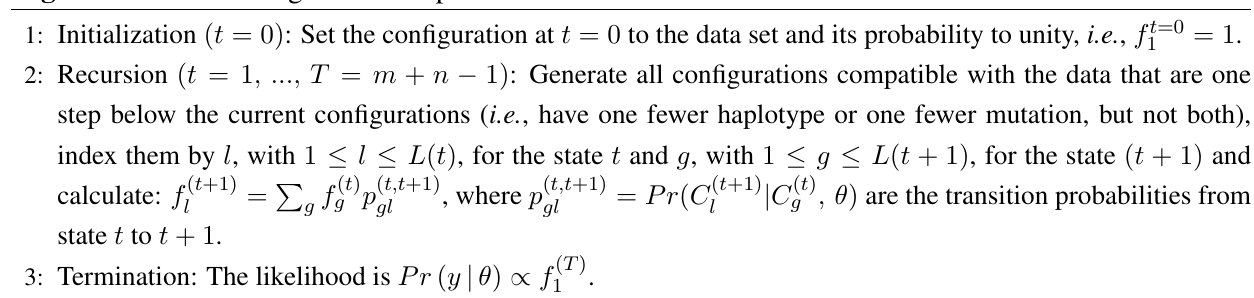
Algorithm 1 Estimating Time-Independent θ